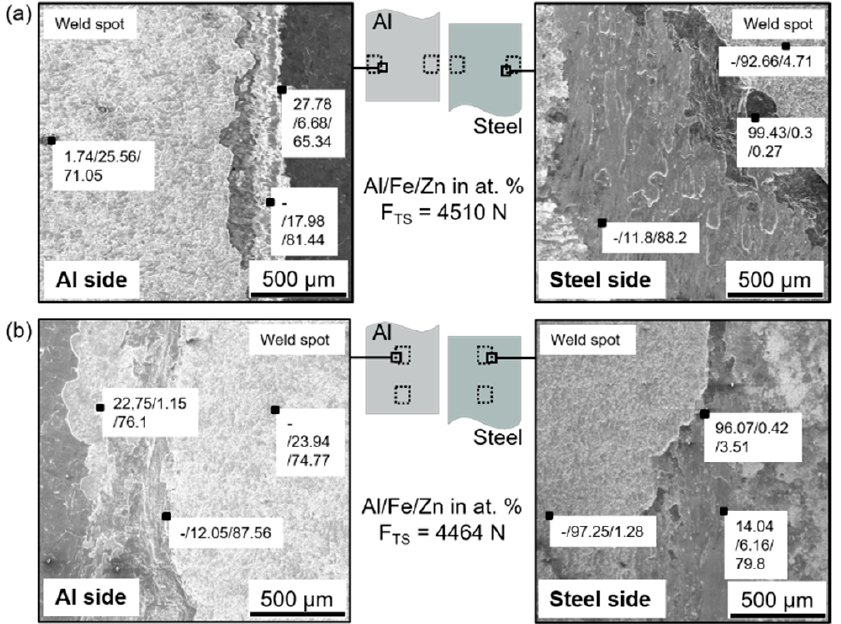
Figure 8. SEM images including EDX spot measurements of the fractured surfaces after tensile shear tests for ( a ) parallel and ( b ) series configuration.